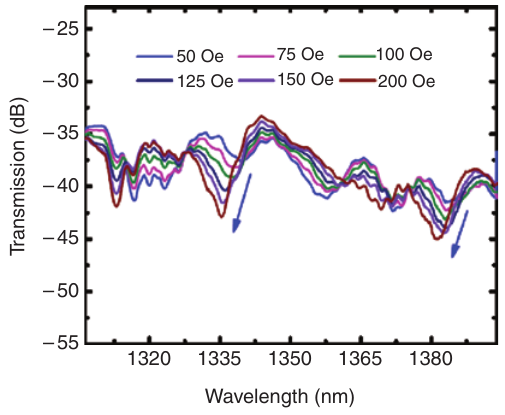
Figure 4: Transmission spectral evolutions of the all-solid WAF with periodic microtapers under different magnetic field intensities.